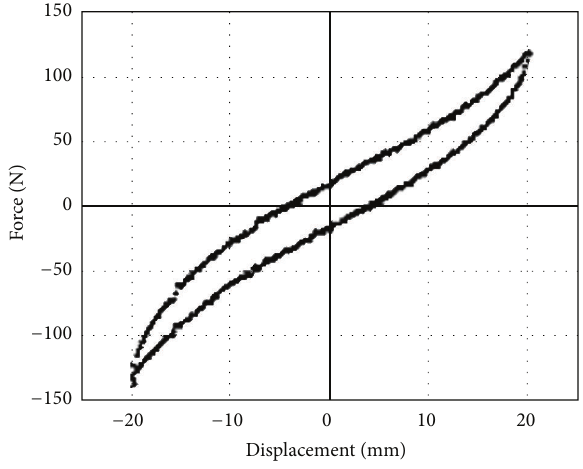
Figure 6: Hysteresis cycle with hardening [9].